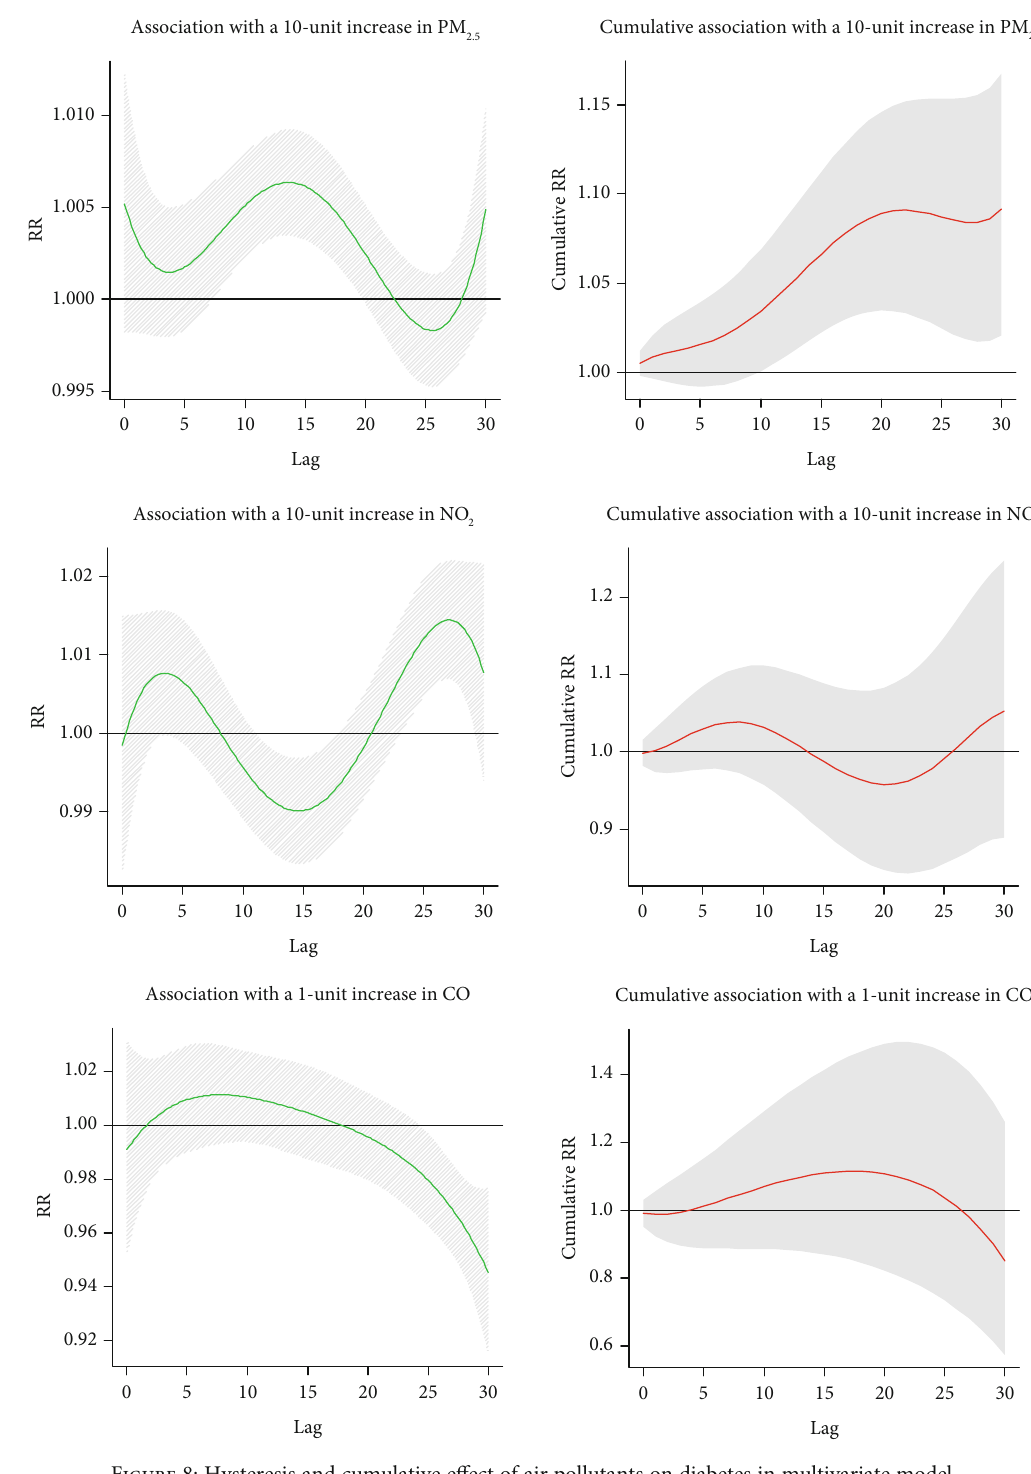
Figure 8: Hysteresis and cumulative e ff ect of air pollutants on diabetes in multivariate